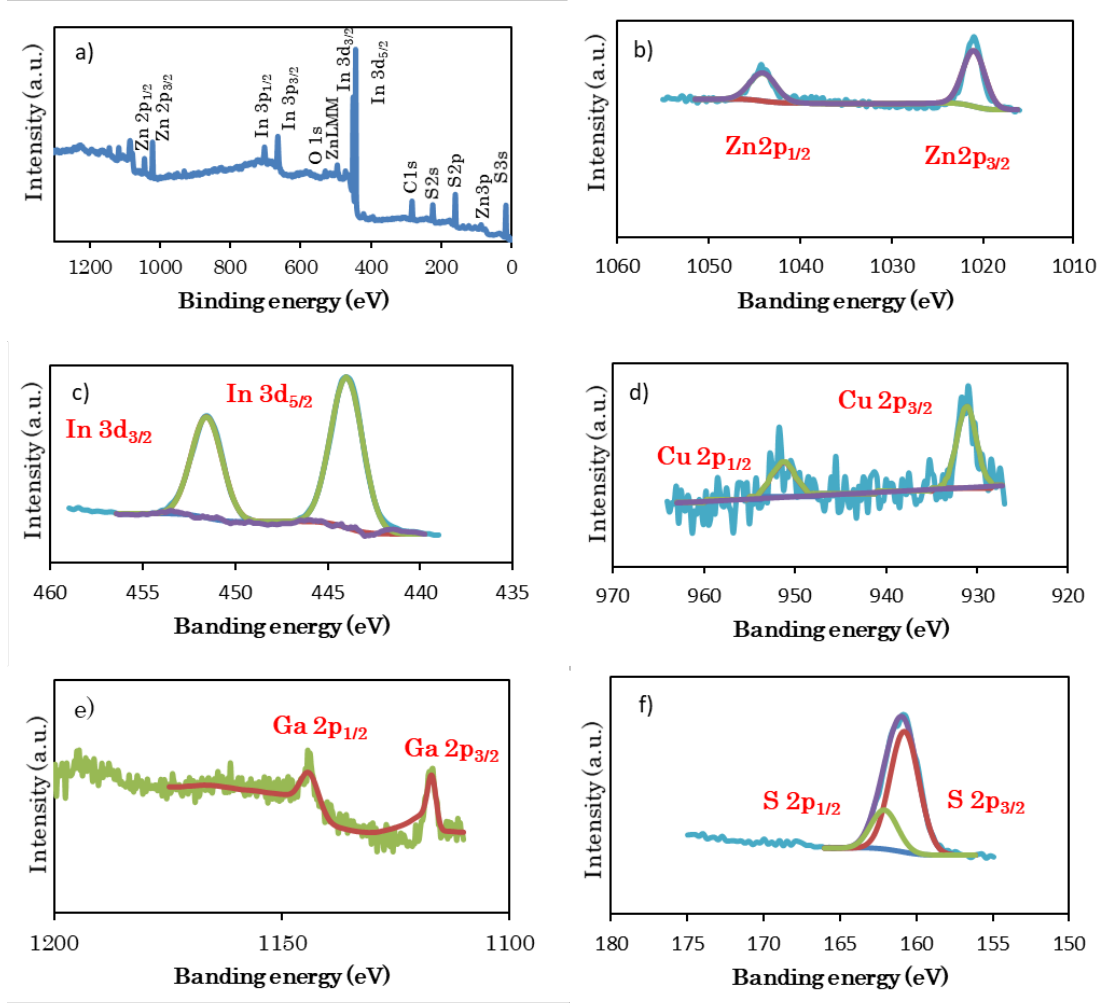
Figure 2. XPS narrow and survey spectra of Zn 0.62 (CuGa) 0.19 In 2 S 4 . ( a ) survey, ( b ) Zn, ( c ) In, ( d ) Cu, ( e ) Ga, and ( f ) S.